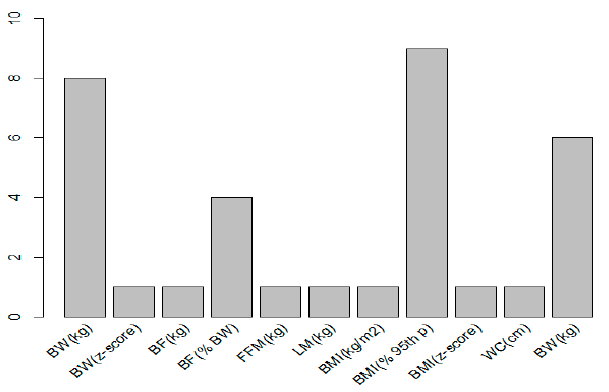
Figure 2. Number of articles within the study of the corresponding parameter and unit.